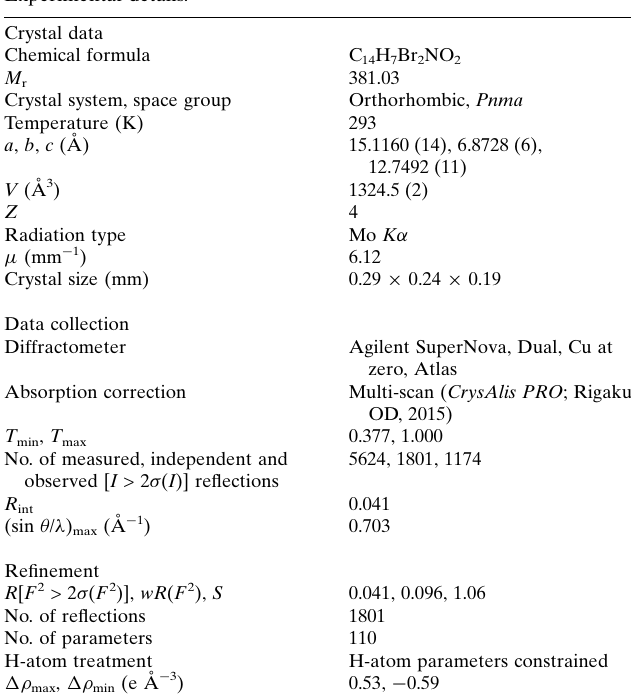
Table 2 Experimental details.